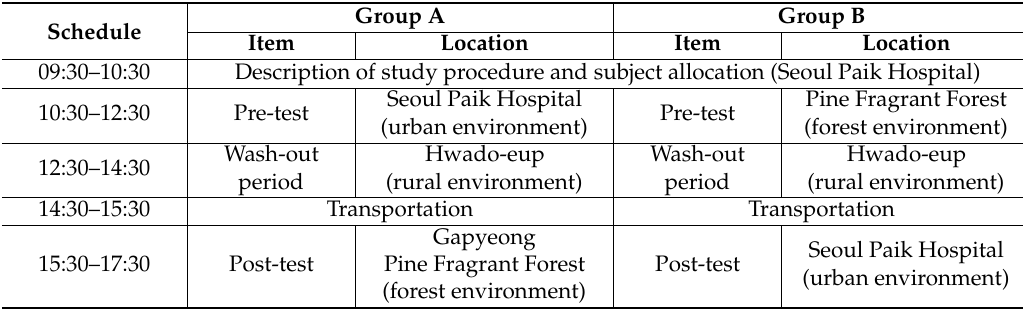
Table 2. Experimental protocol for subjects exposed to the forest or urban